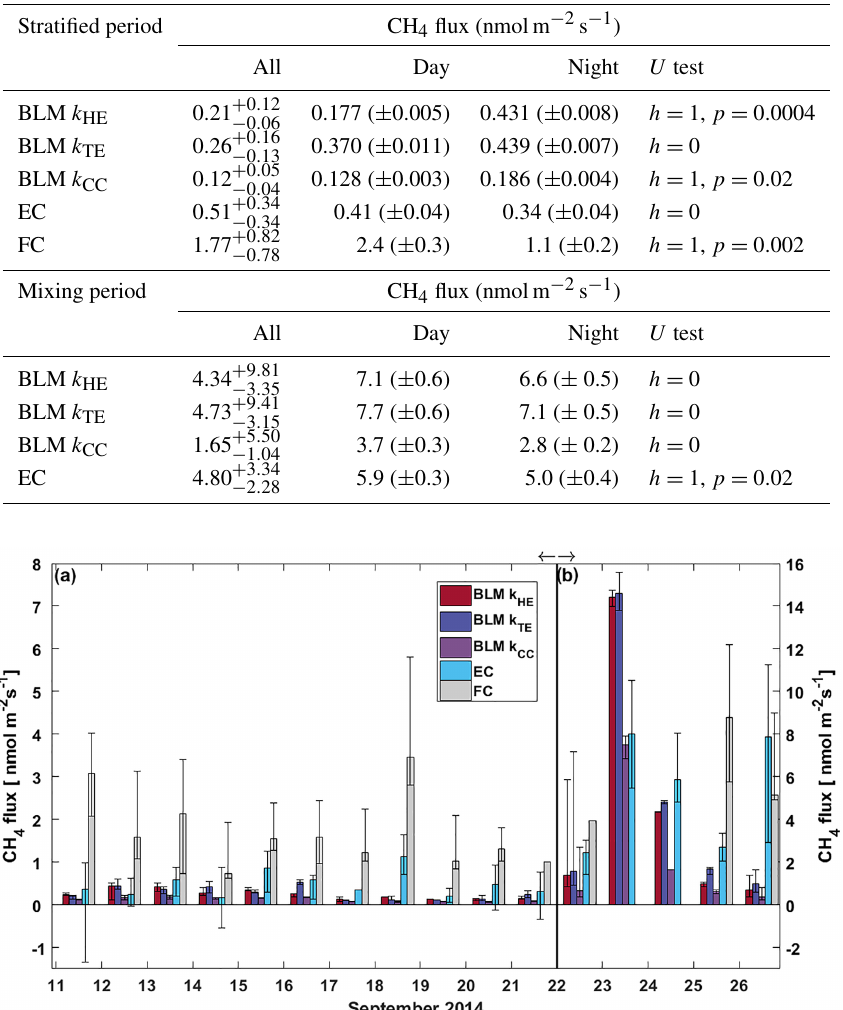
Figure 4. Daily median CH 4 flux from BLM, EC and FC methods. The black whiskers indicate the 25th and 75th percentiles, respectively. The vertical black line represents the start of the lake mixing period. Fluxes during (a) the stratified period (11–21 September) are read from the left and (b) mixing period fluxes (22–26 September) from the right y